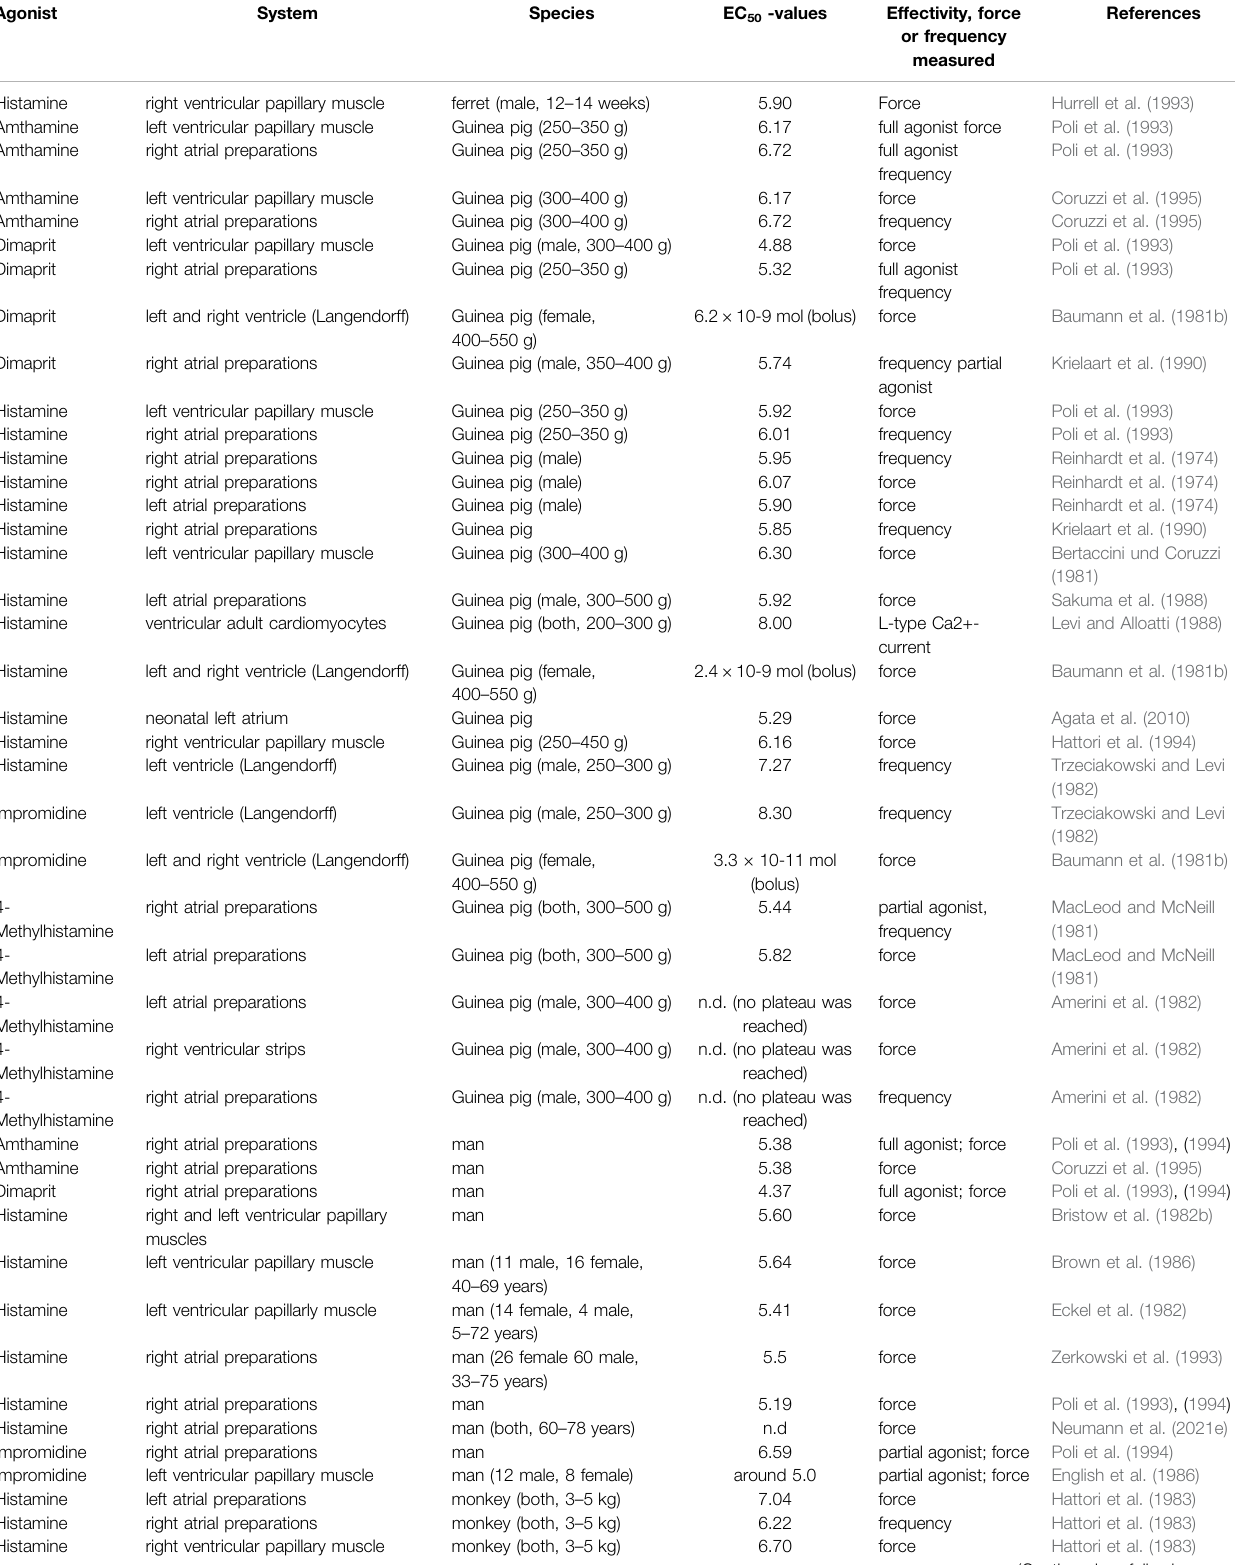
TABLE 8 | EC 50 -values for H 2 -histamine receptor agonists on isolated cardiac preparations from various species.